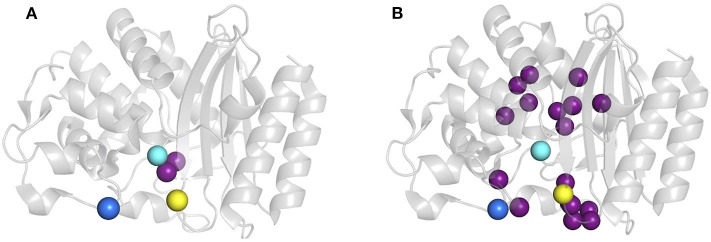
Location of mutations E104K and G238S in host ß-lactamases. (A) cTEM-2m (PDB 4mez) and (B) cTEM-17m (PDB 4id4). Mutated residues with respect to TEM-1 are highlighted as purple spheres and the catalytic serine 70 is in cyan, E104K in dark blue and G238S in yellow.